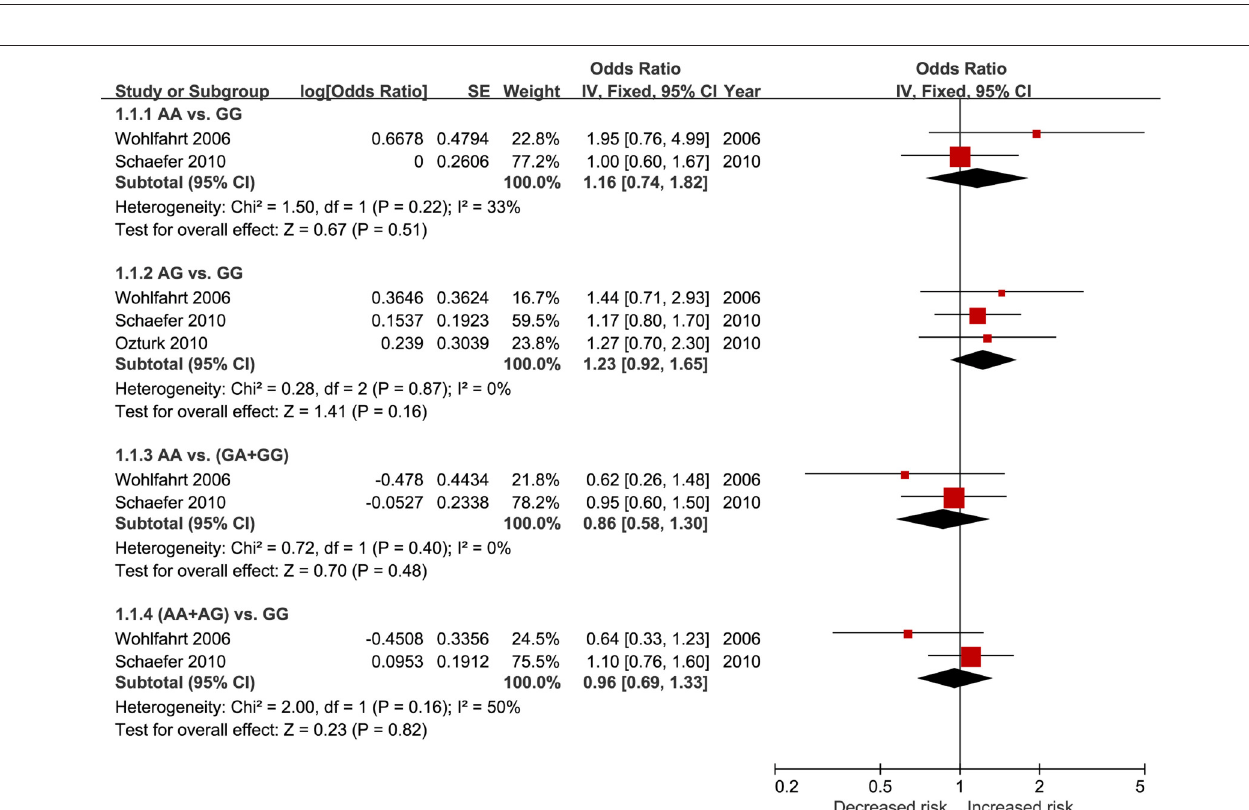
FIGURE 3 | Sensitivity analysis plot of overall analysis in homozygote comparison. CI, Confidence interval.